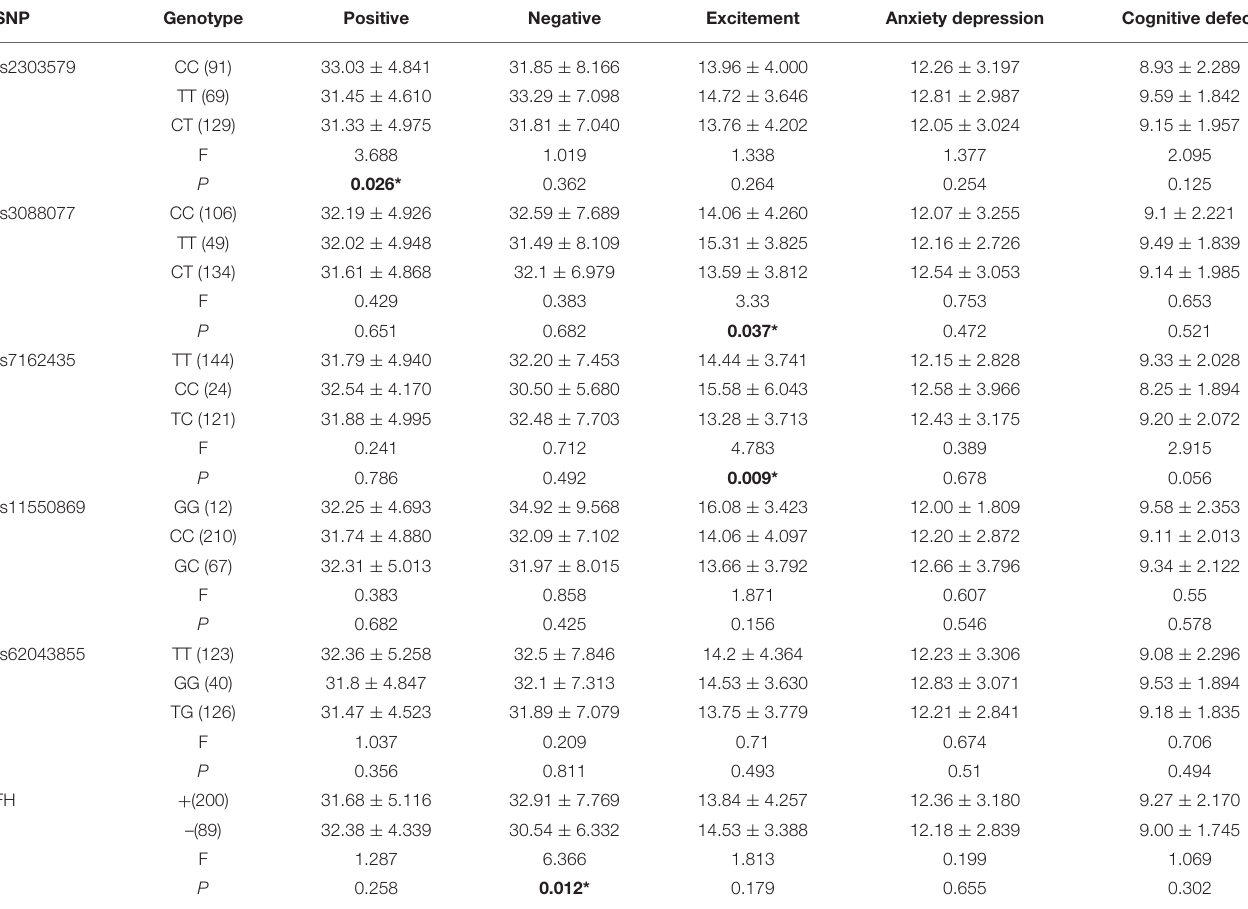
TABLE 4 | One-way analysis of variance of PANSS scores in terms of genotype and FH. SNP Genotype Positive Negative Excitement Anxiety depression Cognitive